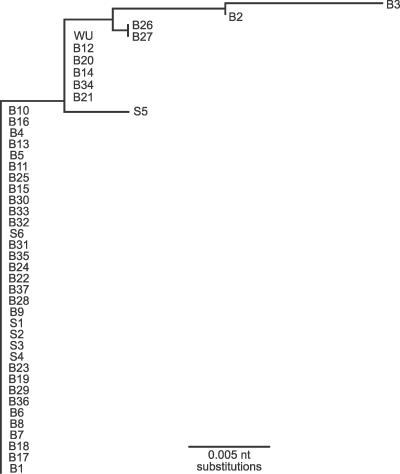
Strain Variation of WU virusA 250-bp fragment of the VP2 gene was aligned using ClustalX. WU indicates the original case, and strain designations correspond to patients as listed in Table 2.